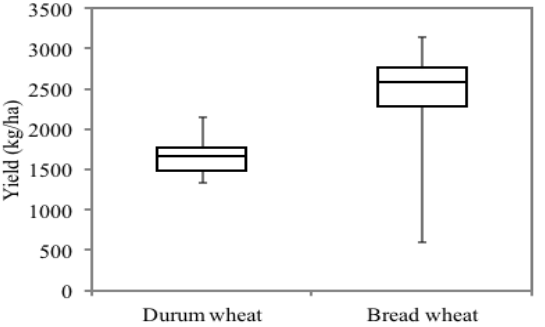
Figure 6. Mean, upper and lower quartile values for bread and durum wheat yield (kg · ha −1 ). Maximum and minimum values are also indicated by whiskers. Each group corresponded to a single species and 25 varieties were used for the